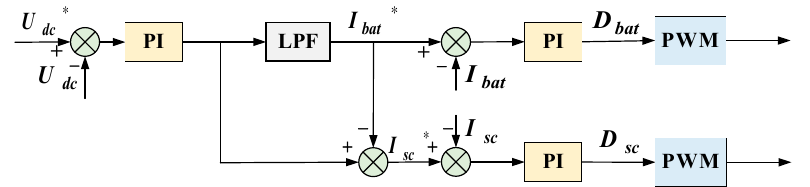
Figure 4. The traditional HESS low-pass filter power allocation strategy based on PI control.